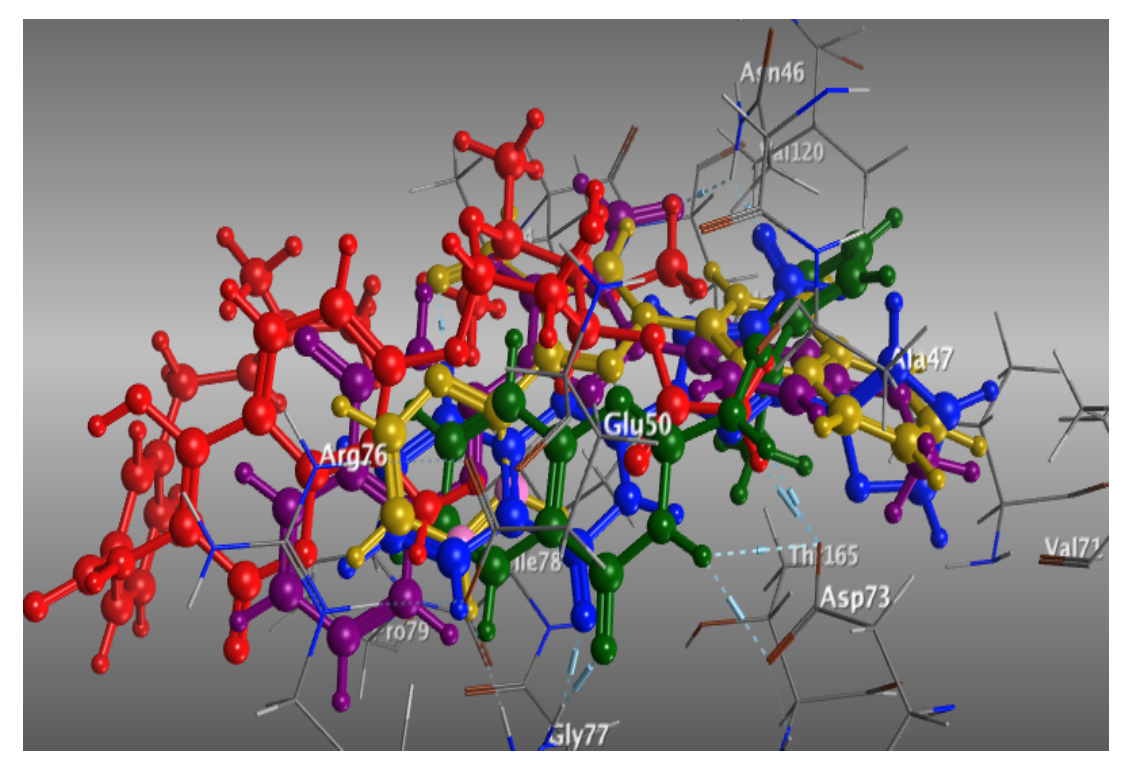
Figure 5. The 3D superimposition between the most potent compounds, 4a (green), 5a (blue), 5c (yellow), and 5d (purple), and the docked original ligand, Novobiocin (red), within the binding site of E. coli DNA gyrase B (PDB code: 1AJ6).